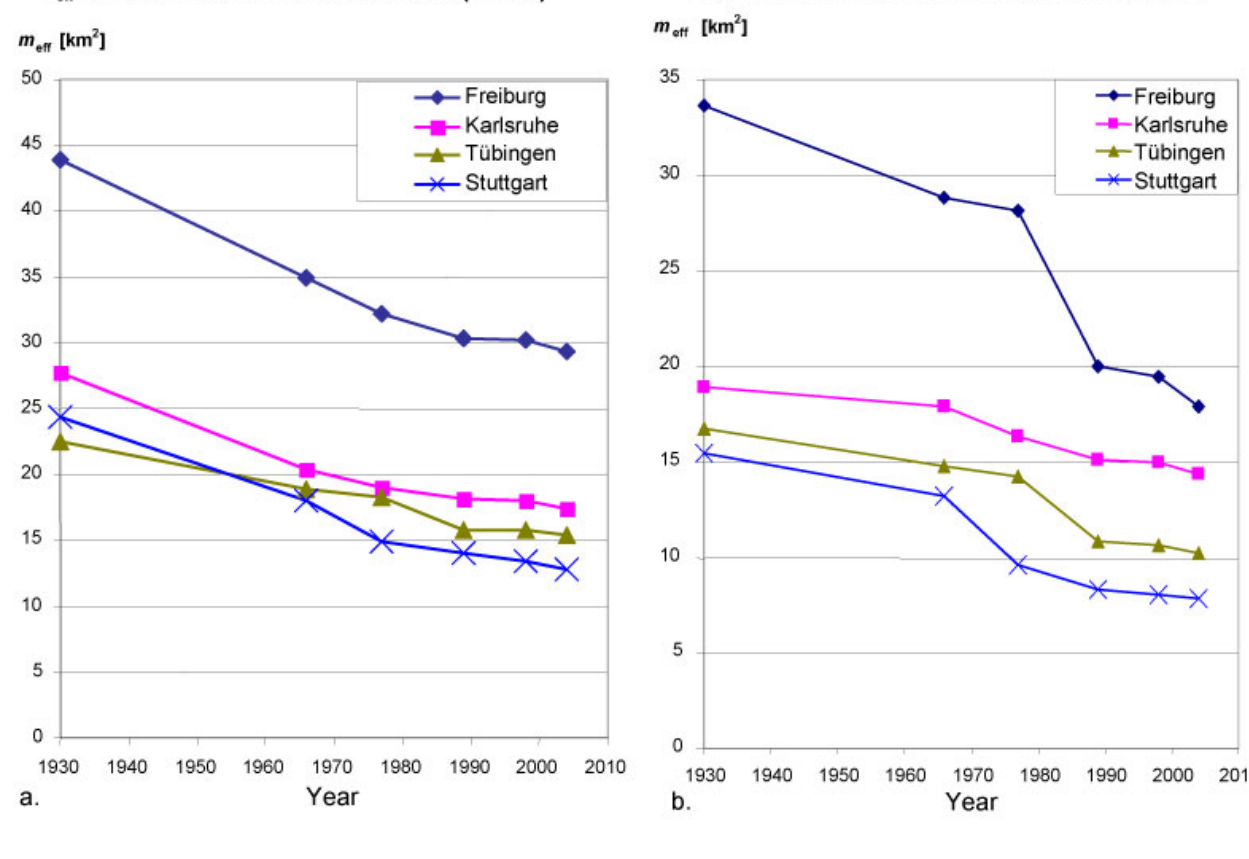
Fig. 4. Time series of the degree of landscape fragmentation in terms of effective mesh size ( m the four administrative districts in Baden-Württemberg from 1930 to 2004 (in km²; without noise bands). a: excluding municipal roads; b: including municipal